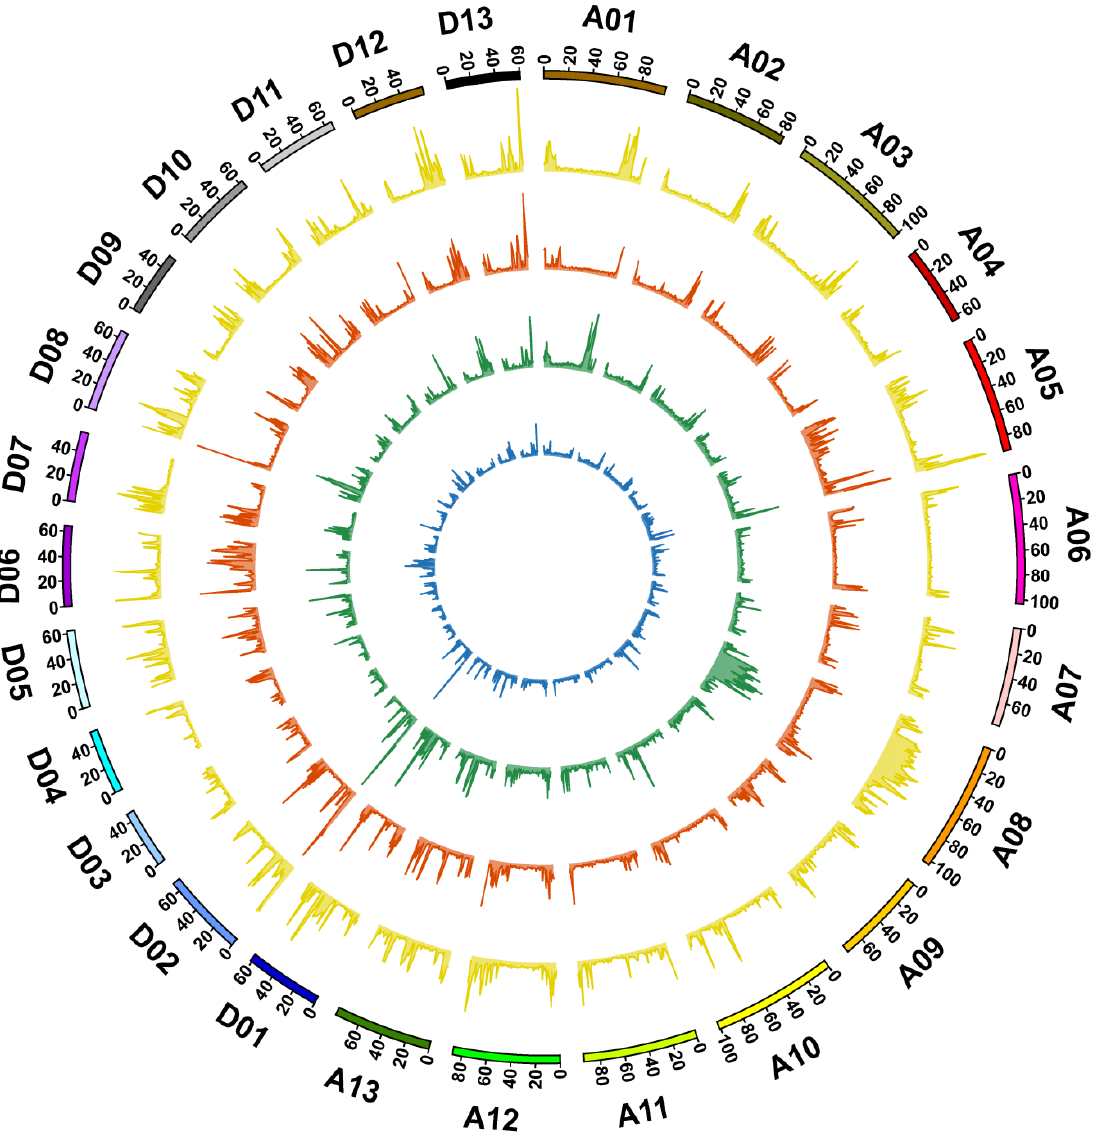
Figure 2. Genome-wide landscape of genetic variation in 9053 and sGK9708. From outside to inside: chromosomes, the single nucleotide polymorphisms (SNP) density of 9053, the SNP density of sGK9708, the insertions/deletions (InDel) density of 9053, and the InDel density of sGK9708, respectively. The density of DNA polymorphisms was calculated among all 26 chromosomes of cotton with a 1-Mb window